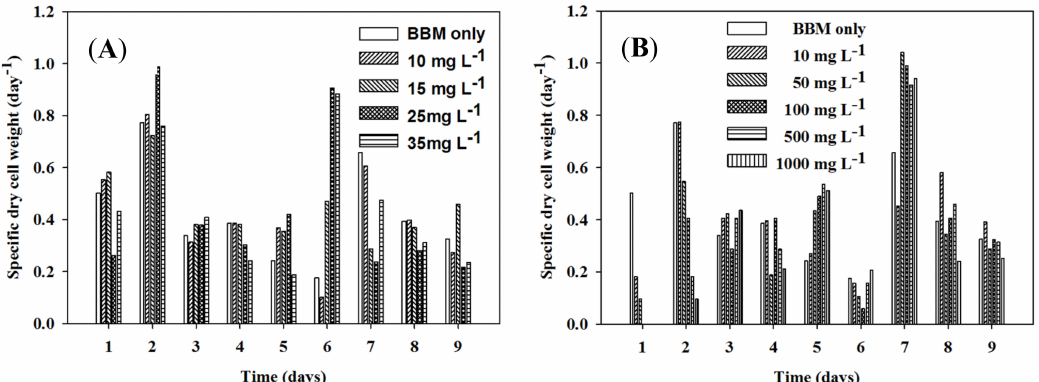
Figure 4. Changes on the specific growth rate of Uronema sp. KGE 3 under the e ff ect of iron ( A ) and ammonium ( B ) cultivated for 9 days in Bold’s Basal Medium